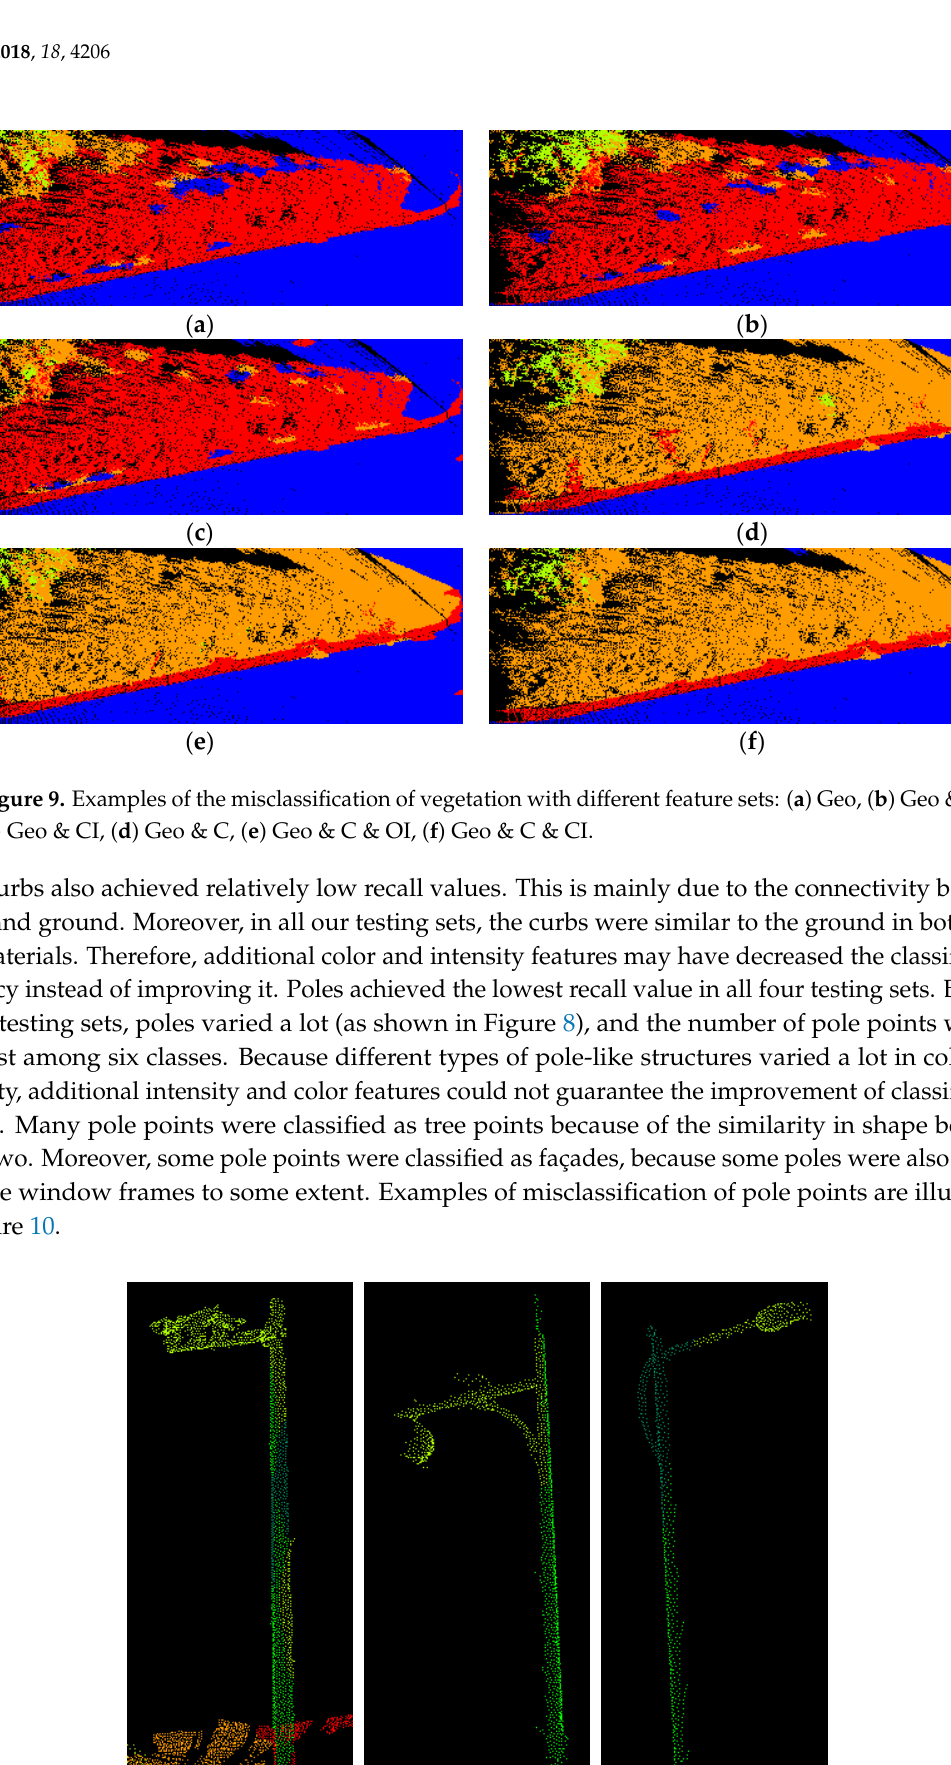
Figure 10. Examples of the misclassification of pole points.